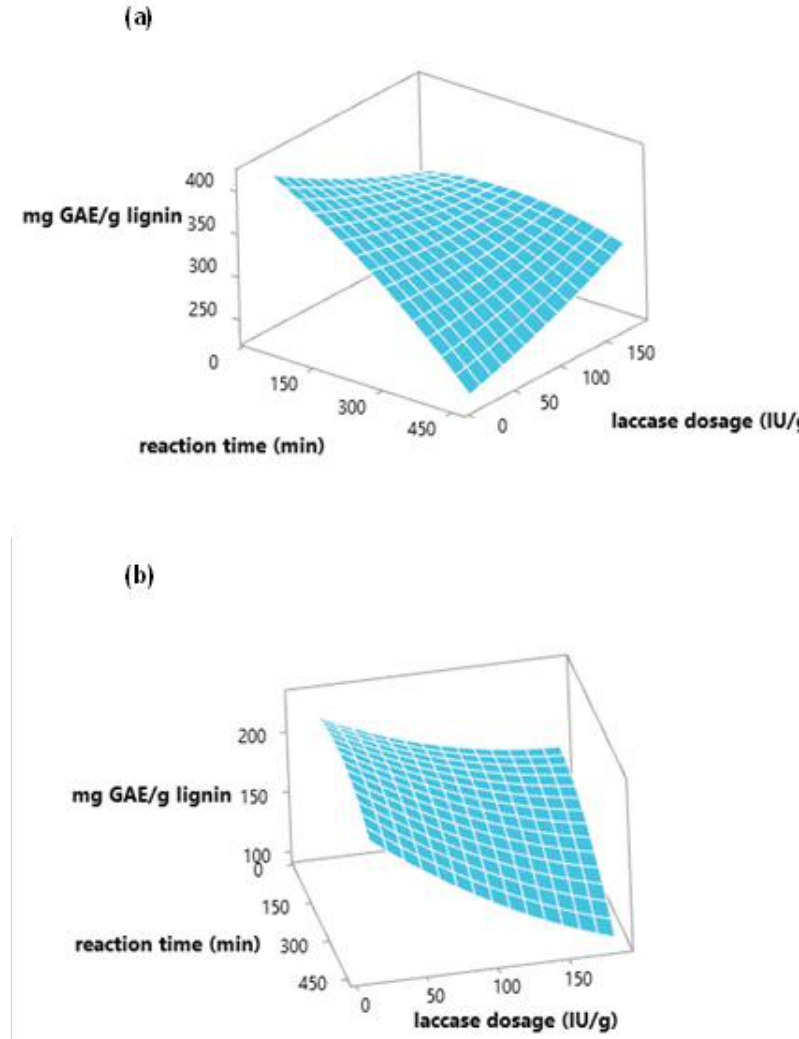
Figure 2. Response surface plot of total phenolic content expressed as mg GAE/g lignin to evaluate MtL ( a ) and SiLA ( b ) laccases dosage and reaction time.